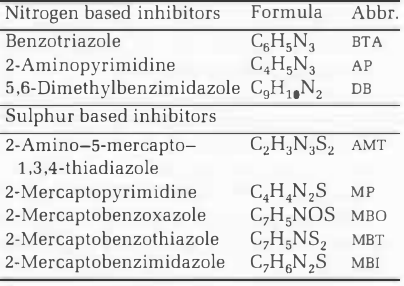
Table 1 Corrosion inhibitors. Nitrogen based inhibitors Formula